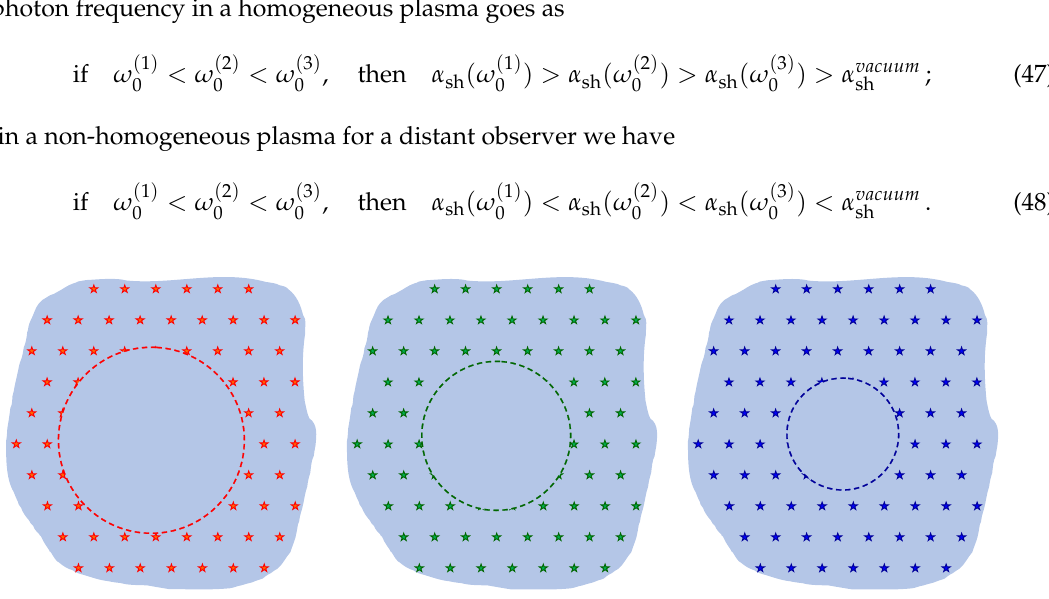
Figure 11. If a black hole is surrounded by a plasma, the observed angular size of the shadow depends on the photon frequency. Note that the picture is schematic, the angular radius is not the result of the calculations. Red color has a longer wavelength than blue, so this picture corresponds to a change in the size of the shadow when a black hole is located in homogeneous